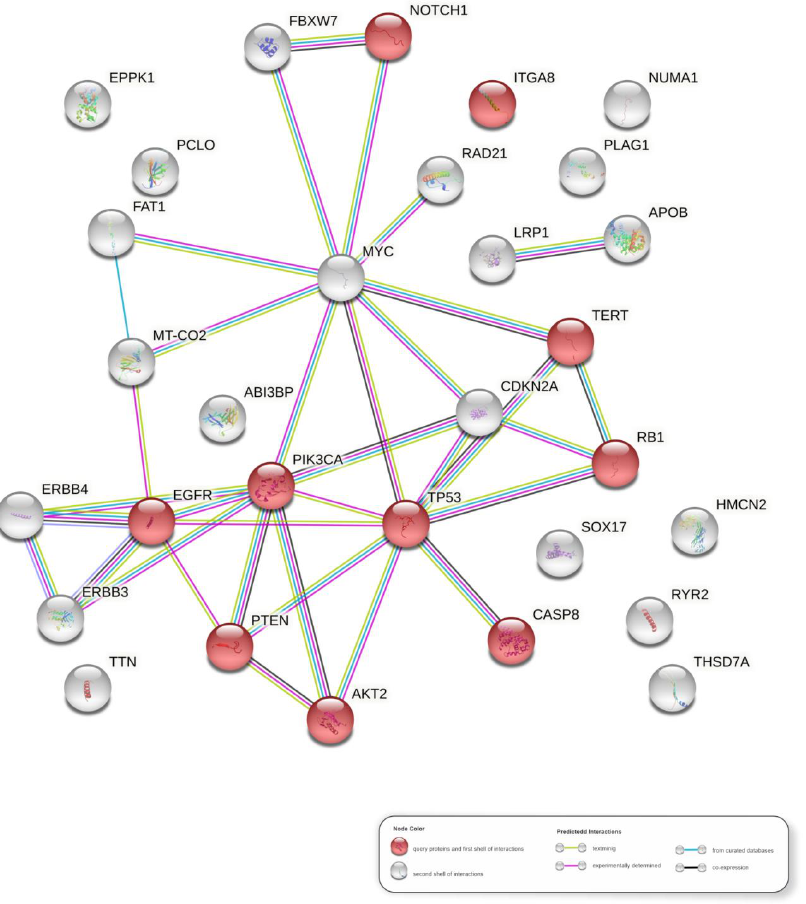
Figure 5. Protein–protein interaction network of the main genes presenting somatic variants in human papillomavirus-associated penile squamous cell carcinomas from Latin Americans. The red nodes represent genes supporting the human papillomavirus infection pathway.